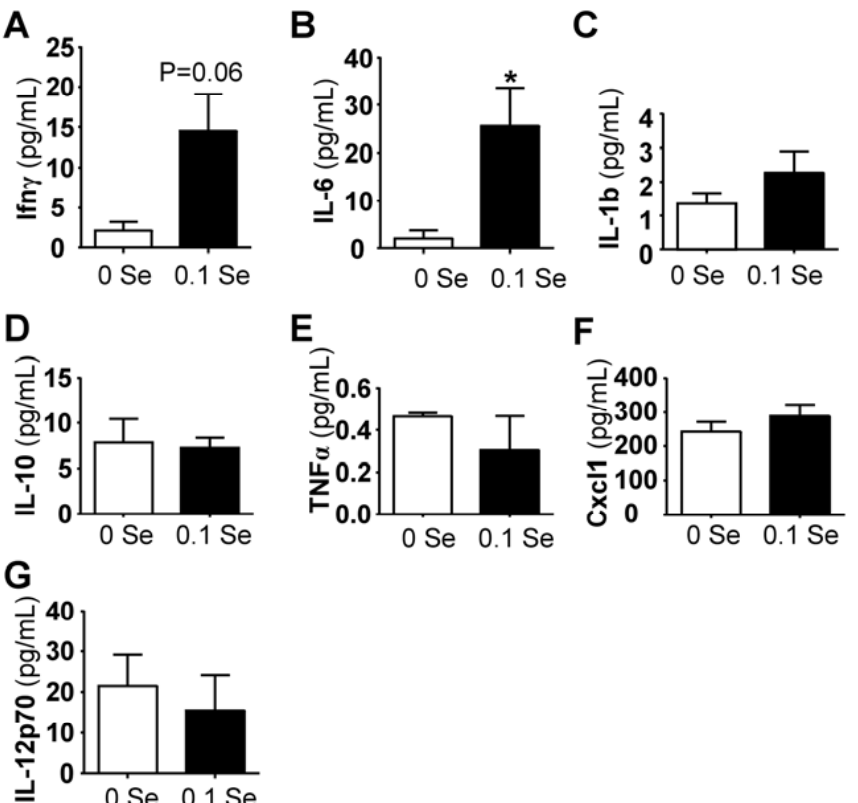
Figure 5. Serum cytokine analysis. Cytokine levels are expressed in pg/mL serum. The columns represent the mean ( N = 5) and standard error of each respective cytokine in mice fed 0 ppm (unshaded bar) or 0.1 ppm Se (shaded bar) supplemented diets. (* p < 0.05 compared to 0 Se).